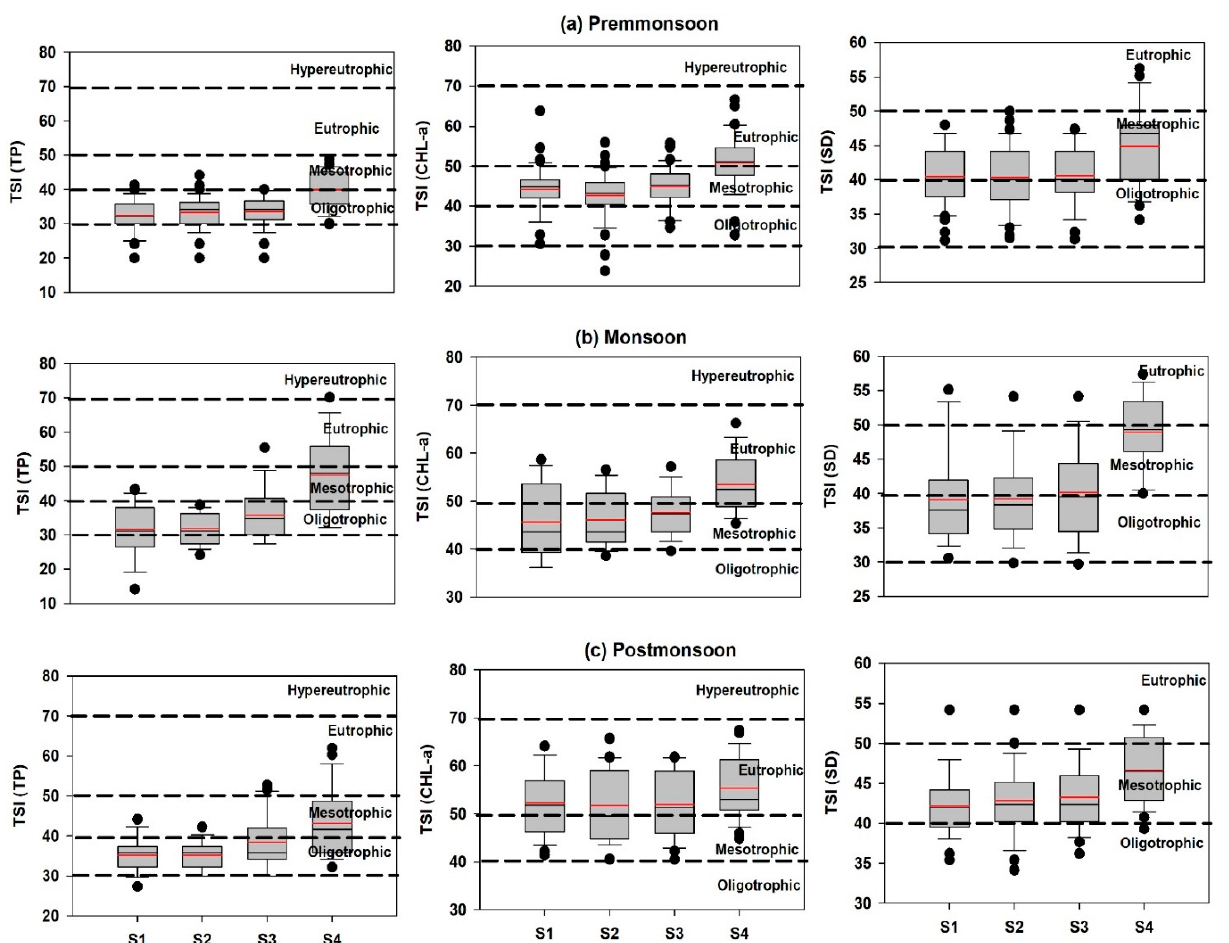
Figure 7. Trophic state index based on total phosphorus (TP), chlorophyll-a (CHL-a), and Secchi depth (SD) of the Yongdam Reservoir during the ( a ) pre-monsoon, ( b ) monsoon, and ( c ) post-monsoon seasons over the period 2013–2019.